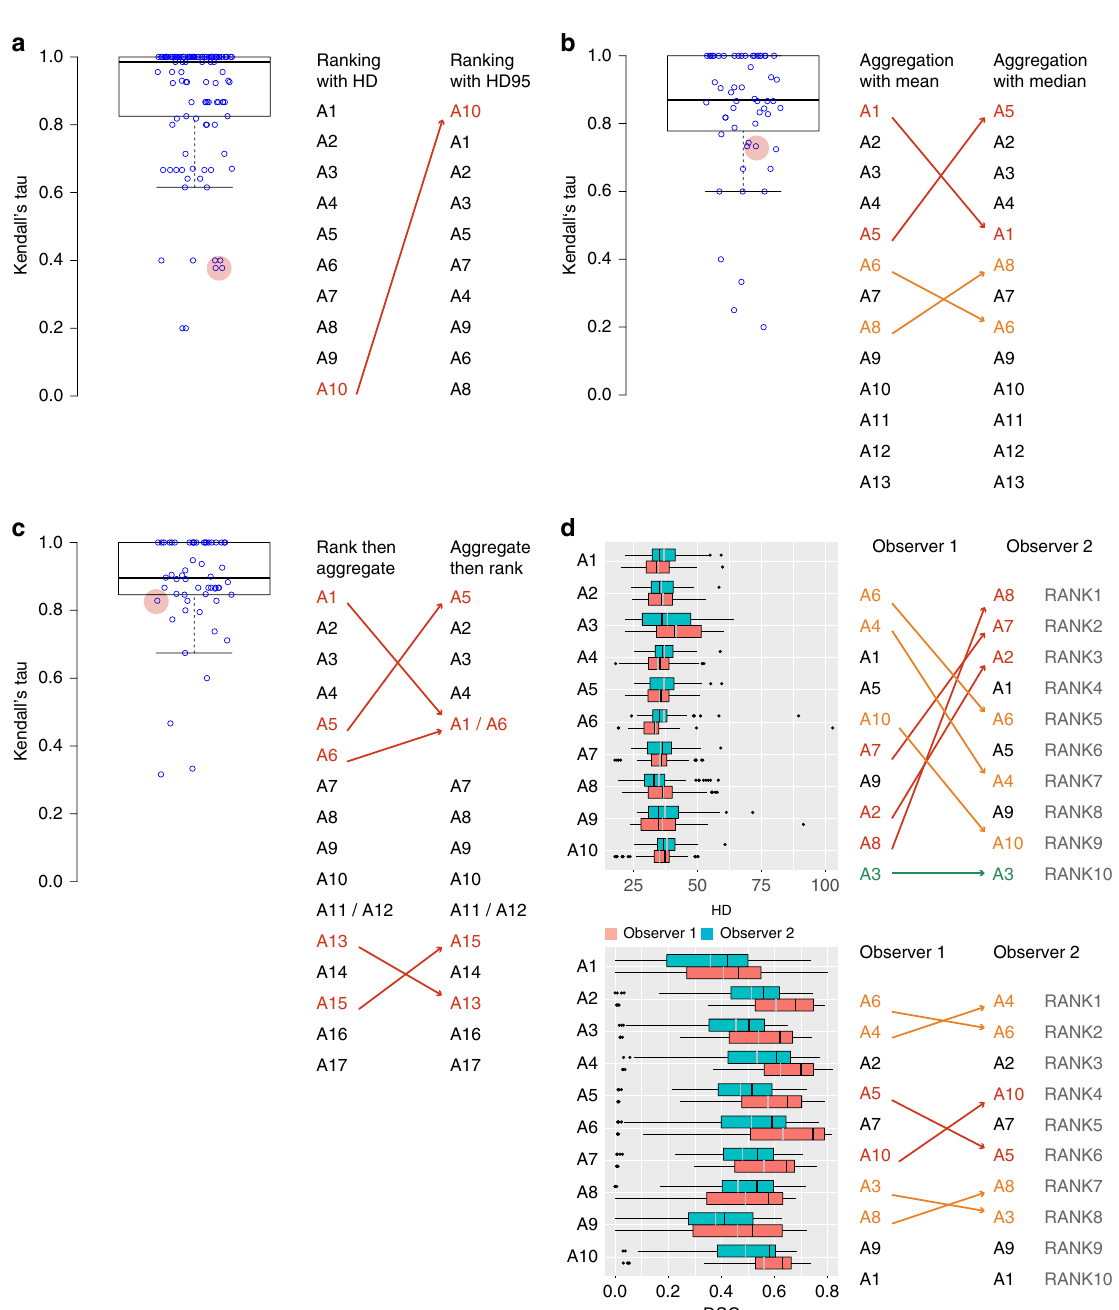
Fig. 2 Robustness of rankings with respect to several challenge design choices. One data point corresponds to one segmentation task organized in 2015 ( n = 56). The center line in the boxplots shows the median, the lower, and upper border of the box represent the fi rst and third quartile. The whiskers extend to the lowest value still within 1.5 interquartile range (IQR) of the fi rst quartile, and the highest value still within 1.5 IQR of the third quartile. a Ranking (metric-based) with the standard Hausdorff Distance (HD) vs. its 95% variant (HD95). b Mean vs. median in metric-based ranking based on the HD. c Case-based (rank per case, then aggregate with mean) vs. metric-based (aggregate with mean, then rank) ranking in single-metric ranking based on the HD. d Metric values per algorithm and rankings for reference annotations performed by two different observers. In the box plots ( a – c ), descriptive statistics for Kendall ’ s tau, which quanti fi es differences between rankings (1: identical ranking; − 1: inverse ranking), is shown. Key examples (red circles) illustrate that slight changes in challenge design may lead to the worst algorithm (A i : Algorithm i) becoming the winner ( a ) or to almost all teams changing their ranking position ( d ). Even for relatively high values of Kendall ’ s tau ( b : tau = 0.74; c : tau = 0.85), critical changes in the ranking may